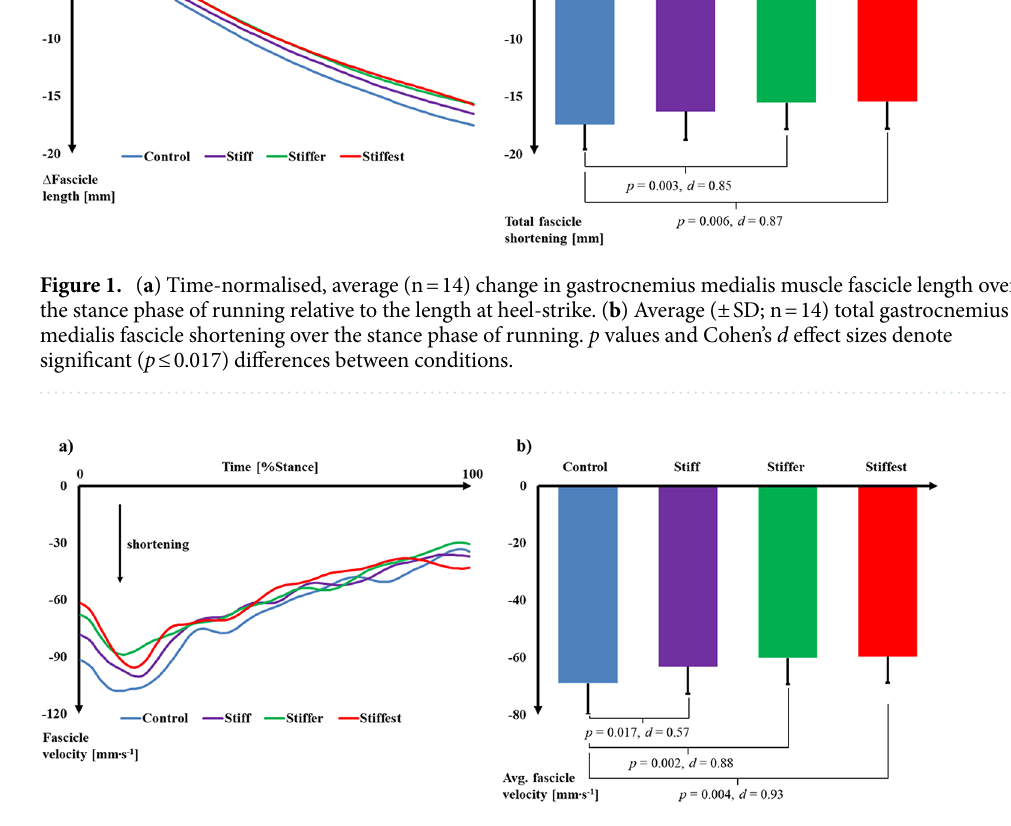
Figure 2. ( a ) Time-normalised, average (n = 14) gastrocnemius medialis muscle fascicle velocity over the stance phase of running. ( b ) Average (± SD; n = 14) gastrocnemius medialis fascicle velocity over the stance phase of running. p values and Cohen’s d effect sizes denote significant ( p ≤ 0.017) differences between